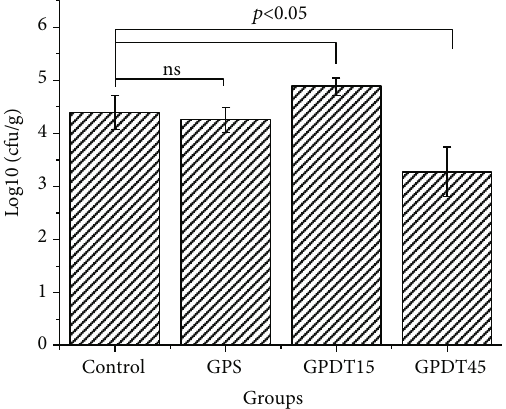
Figure 7: Values of the population of Candida albicans according to the protocol of photodynamic therapy with protoporphyrin IX. NS: no signi fi cance; control: infected lungs; GPS: infected lungs treated with protoporphyrin IX; GPDT15: infected lungs treated with protoporphyrin IX for 15 minutes; GPDT45: infected lungs treated with protoporphyrin IX for 45